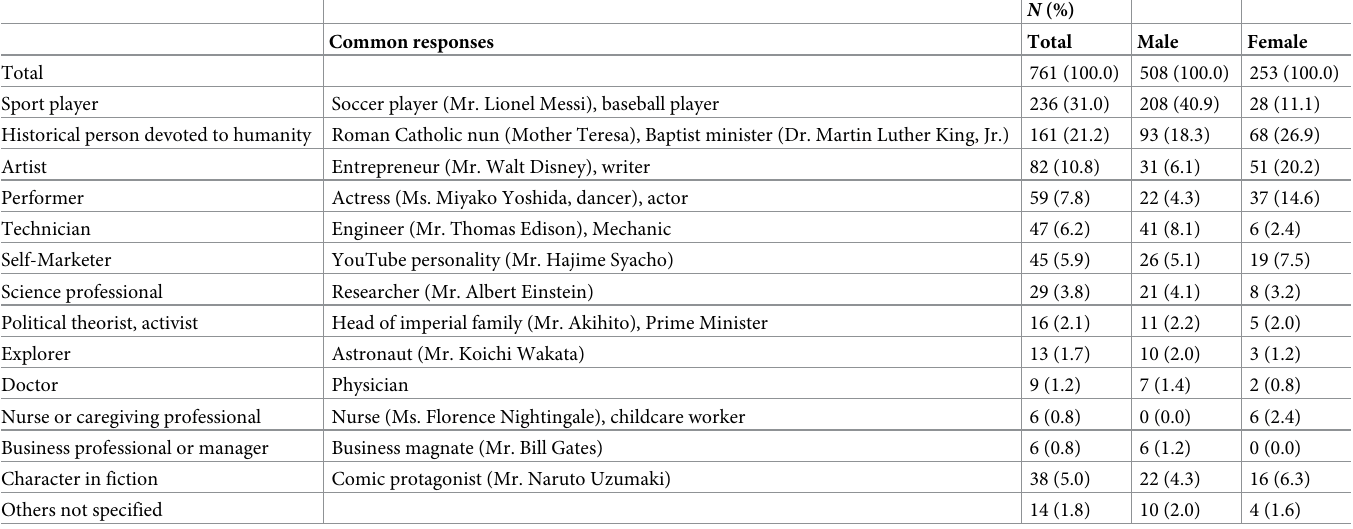
Table 2. Types of figure role models among adolescents (N =